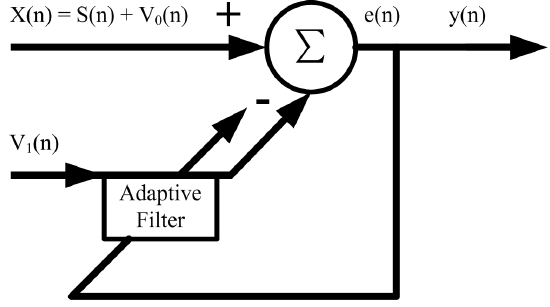
Figure 4. Block diagram of adaptive noise cancellation.